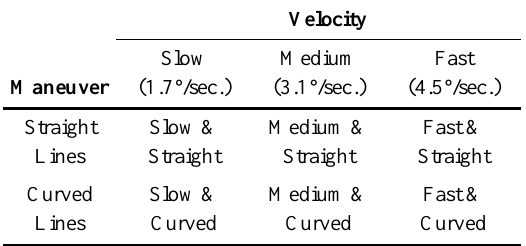
The 6 tracking conditions within an experimental